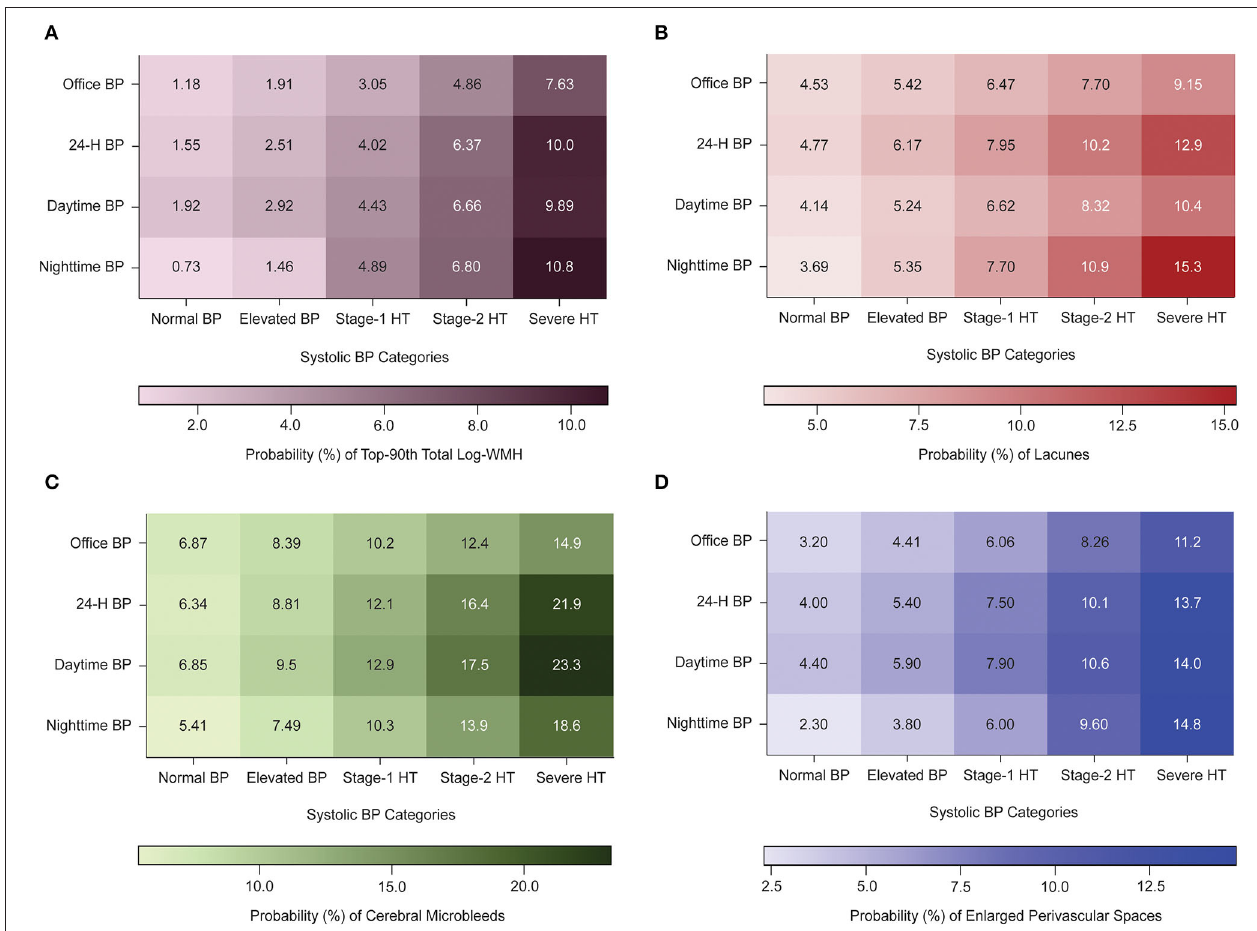
FIGURE 1 | Heat maps displaying the probability (%) of having subclinical markers of cerebral small vessel disease according to office and ambulatory blood pressure Categories. BP indicates blood pressure; WMH, white matter hyperintensities; HT, hypertension. Normal, elevated BP, stage-1, stage-2, and severe hypertensions thresholds were 120/130/140/160mm Hg for office systolic BP, 115/125/130/145 for 24-h, 120/130/135/145 for daytime, and 100/110/120/140 for nighttime BP. Numbers inside the box indicates the probability of having top-90th total log-WMH (A) , lacunes (B) , cerebral microbleeds (C) , or enlarged perivascular spaces (D) . The probability was derived by multivariable logistic regression and was standardized to the average of the distributions in the whole study population of sex, age, education, cephalic circumference, body mass index, diabetes mellitus, use of antihypertensive treatment, glomerular treatment, and history of cardiovascular